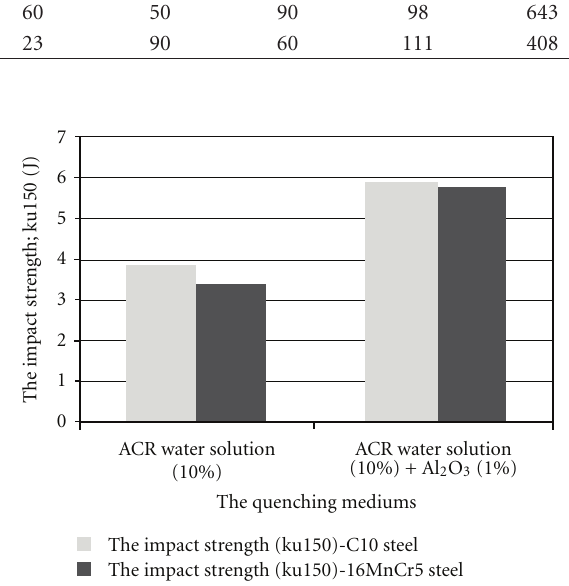
Figure 3: The influence of quenching media on impact strength of hardened and carburized C10 and 16MnCr5 steel